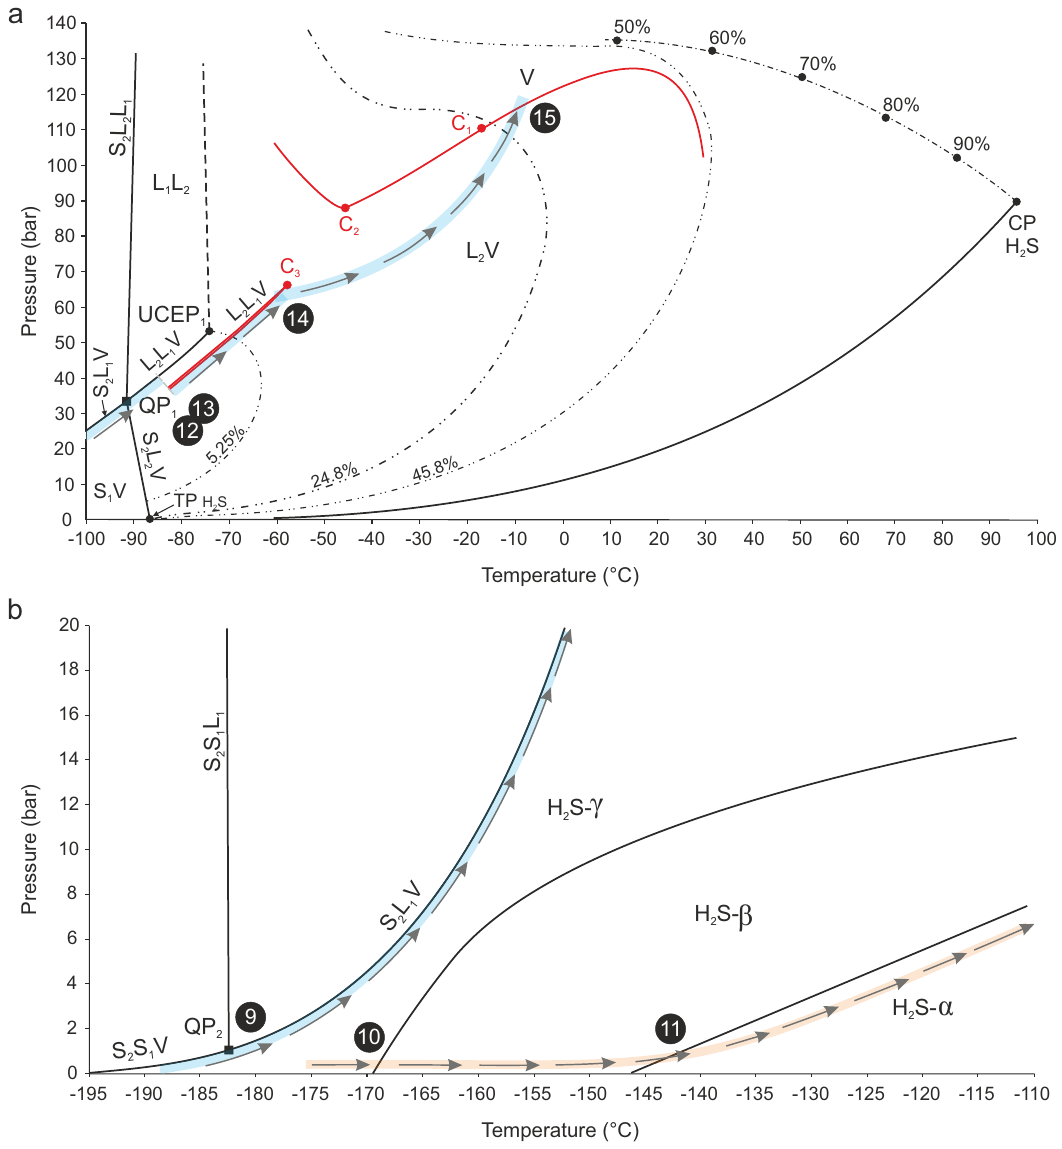
Fig. 8 Phase diagrams schematically illustrating the behavior of studied fl uid inclusions in the P – T space. a Simpli fi ed phase boundaries for the system CH 4 – H 2 S 31 around critical points and the fi rst invariant point-QP 1 with superimposed phase curves for the CH 4 – H 2 S – CO 2 system 58 (in red). b Phase boundaries for the system CH 4 -H 2 S in the lowest temperature region near the 2 nd invariant point-QP 2 point 35 and phase boundaries for pure H 2 S at low temperatures 40 . Symbols and abbreviations: upper dash-dotted line-critical curve with marked critical points for various H 2 S contents; double-dotted dashed lines-immiscibility loops for 5.25, 24.8, and 45.8 mol% H 2 S; thicker pale blue lines and arrows show schematic P – T paths followed by gas